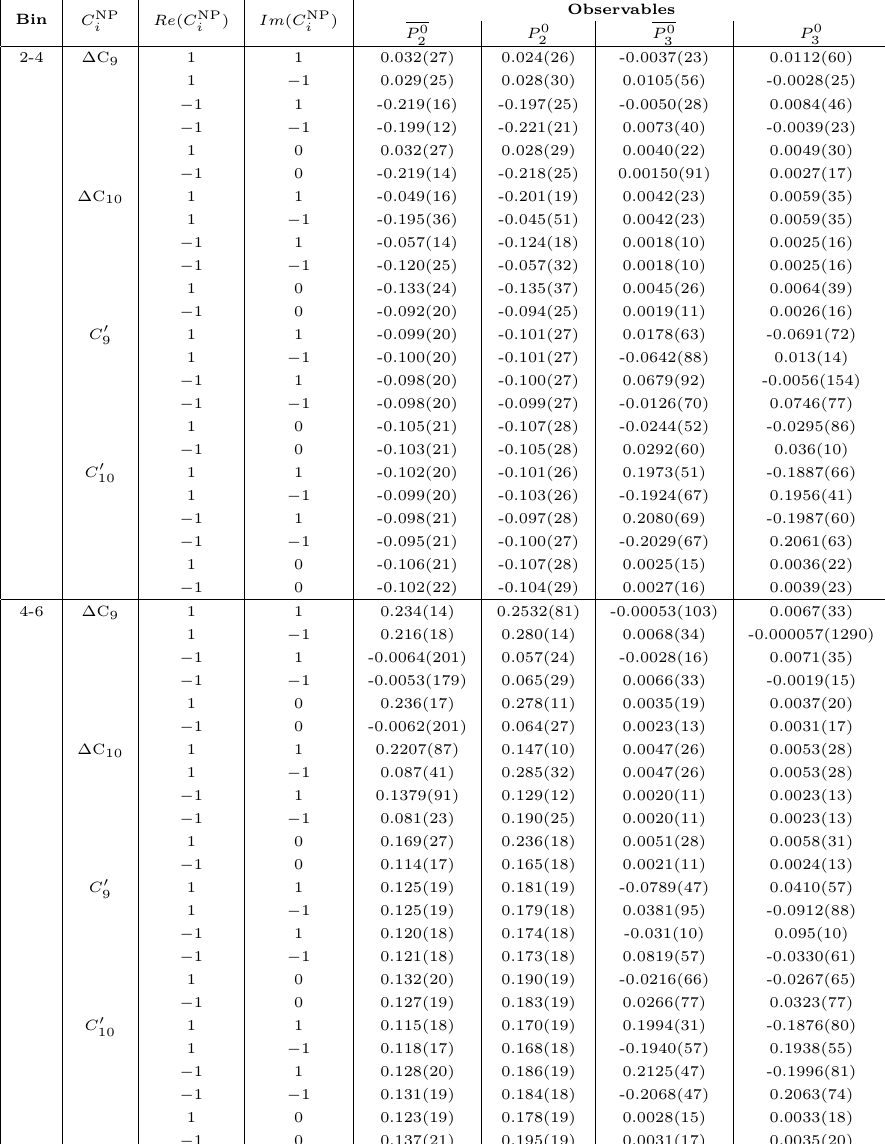
Table 33 . The dependence of some of the optimized observables corresponding to tagged and B 0 → ρ 0 ll on the real and imaginary parts of the NP WC’s ∆ C 2 − 4 and 4 − 6 GeV 2 for a few benchmark values of the real and imaginary parts of the corresponding